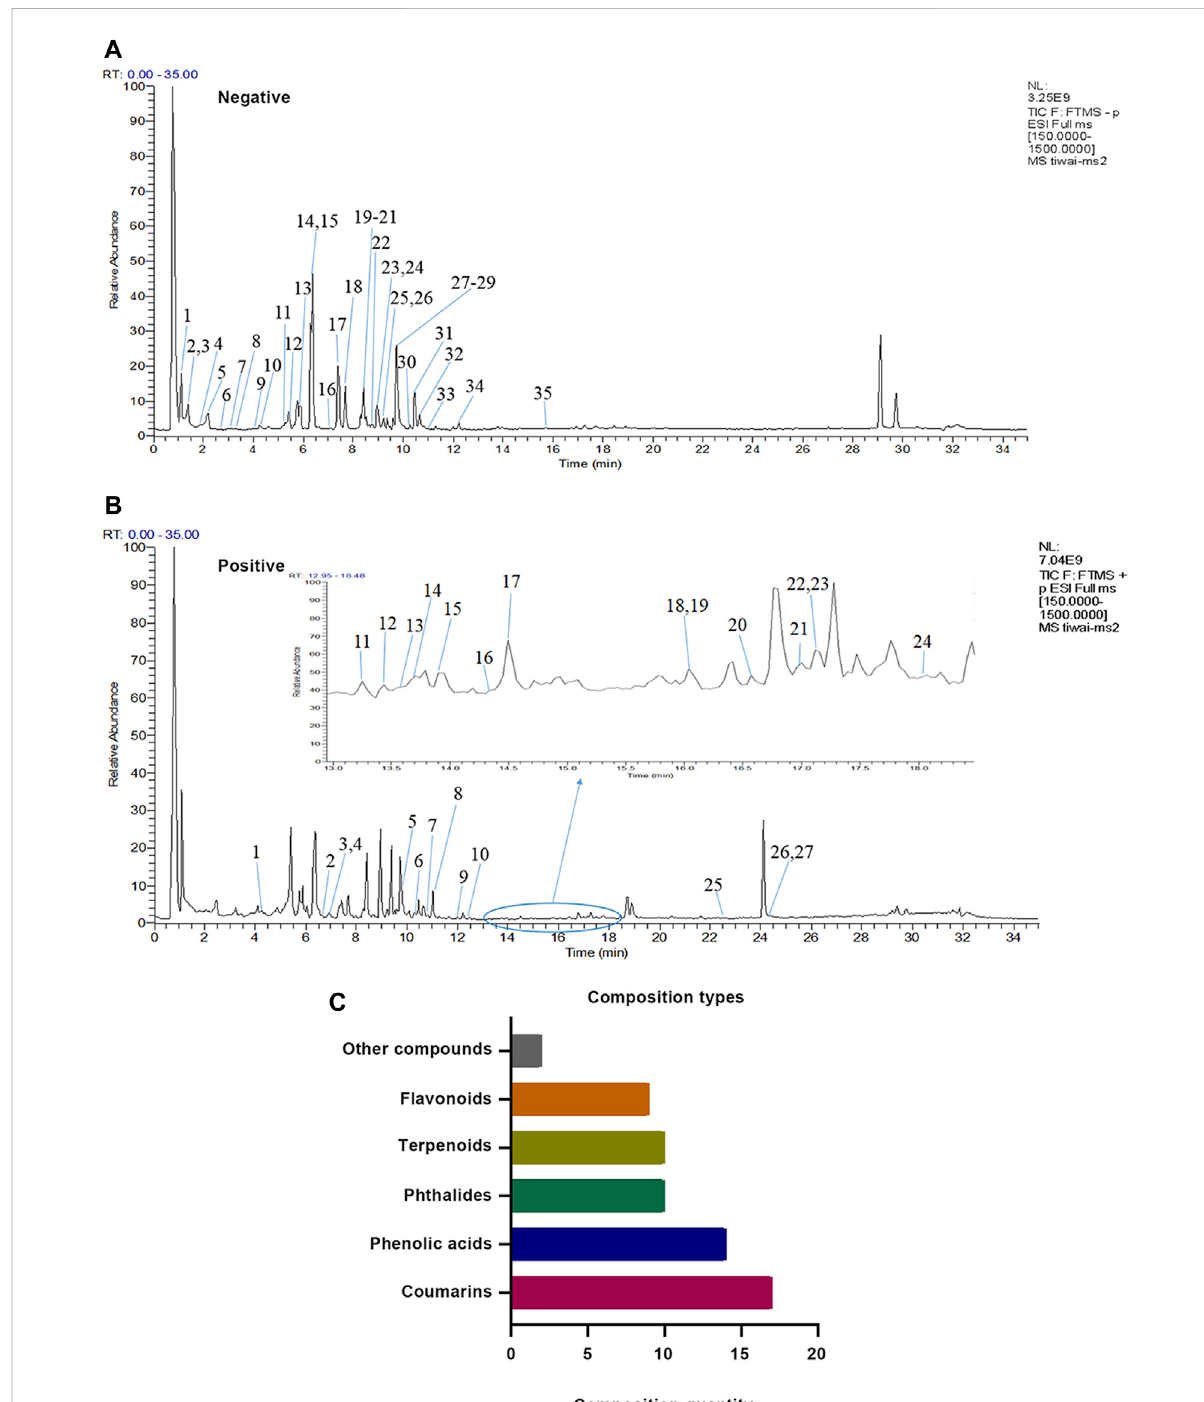
Identi fi cation results of themain chemical components of XZR by UHPLC-LTQ-Orbitrap MS. (A) Total ion fl ow diagram of XZR in anion mode (detailsofNos.1 – 35arelistedin SupplementaryTableS1 ). (B) Totalion fl owdiagramofXZRinthepositiveionmode(detailsofNos.1 – 27arelistedin Supplementary Table S2 ). (C) Identi fi cation of the main components in XZR. XZR, Xiongshao Zhitong